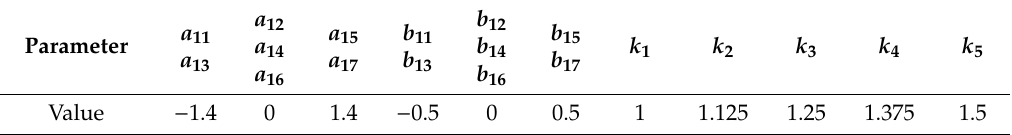
Table 5. Parameters of the fuzzy controller chosen